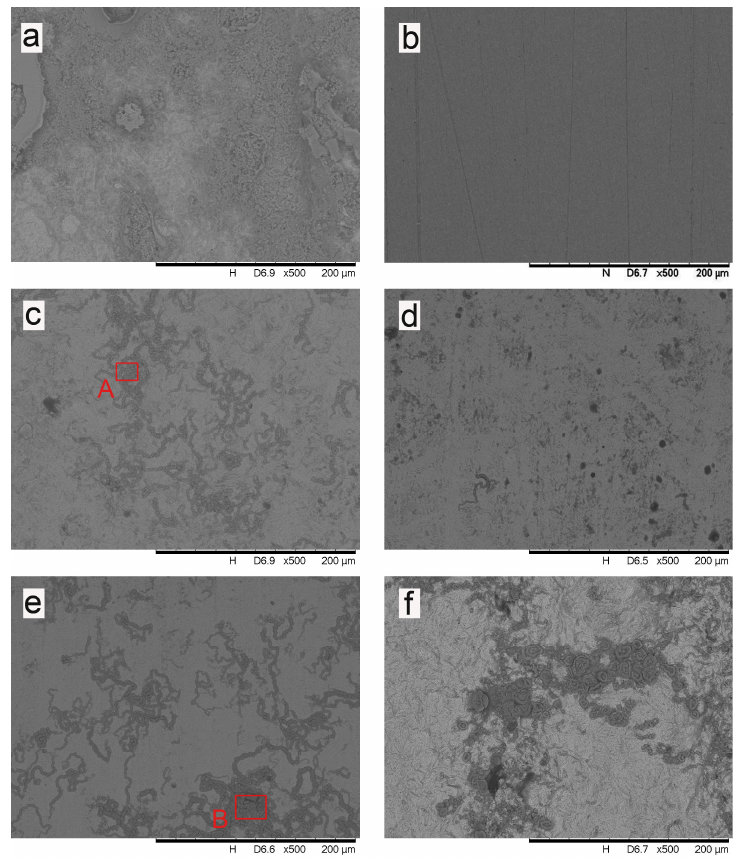
Figure 6. SEM of casing steel after being exposed to fresh and residual acid solutions with or without Mb inhibitor at 90 °C for 4 h: ( a ) 20% HCl; ( b ) 20% HCl + Mb; ( c ) pH 1.0; ( d ) pH 1.0 + Mb; ( e ) pH 3.0; ( f ) pH 3.0 + Mb. Table 3. Elemental composition of the A and B regions (at.%).